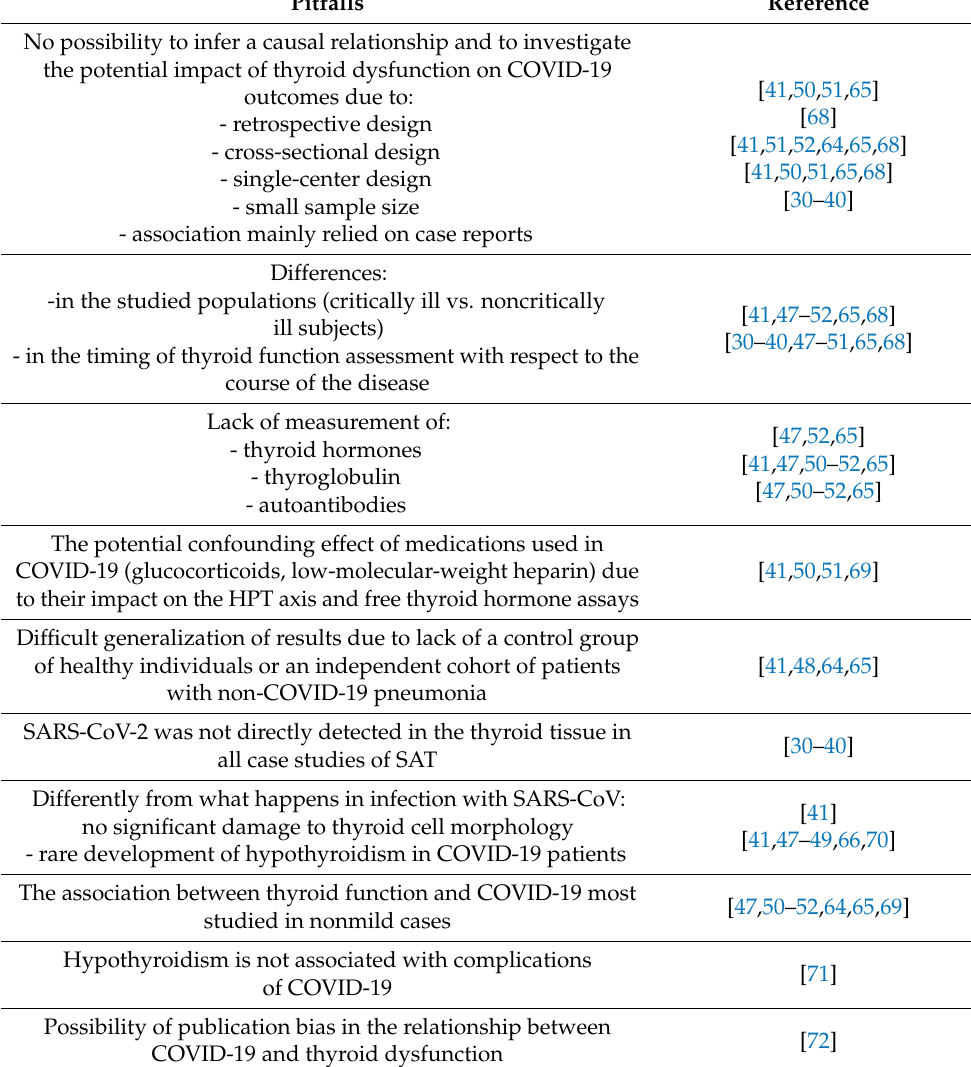
Table 2. Summary of potential pitfalls in the relationship between COVID-19 and thyroid